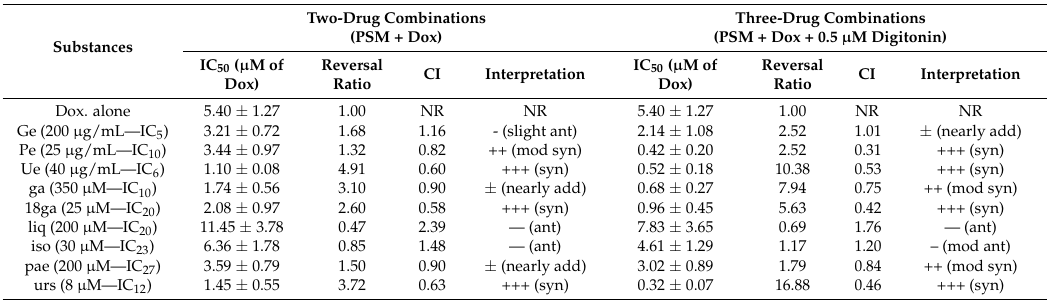
Table 4. Cytotoxicity of doxorubicin alone or in combination with a non-toxic concentration of a single substance or with a single substance plus digitonin against Caco-2 cells. All data were from at least three independent experiments and represented as the mean ± SD. Substances Dox.